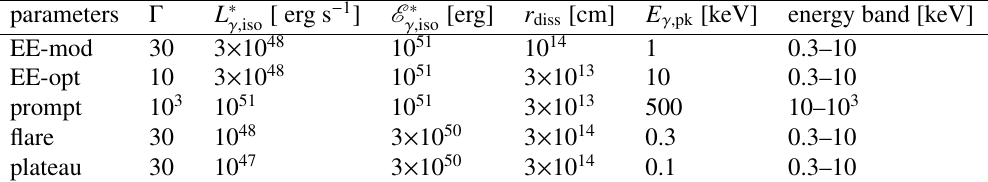
Table 1. Used parameters for each component of SGRBs. Γ is the Lorentz factor of the jet, L ∗ luminosity and energy fluence in the observed energy band, r diss is the dissipation radius, E γ, pk is the observed break energy of the photon spectrum, and the last column shows the energy band of the SGRB observations. This table is adapted from [19].